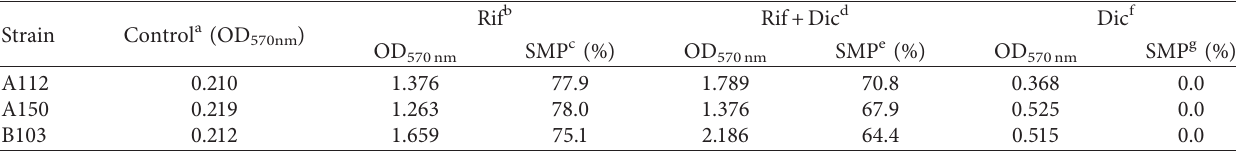
Figure 2: Biofilm production by two (a-b) isolates of S. aureus in tryptone soy broth (TSB) added of subinhibitory concentrations of diclofenac. The horizontal dashed line indicates the cutoff value that separates production from nonproduction of the biofilm. Assays were repeated three times with similar results, and error bars represent mean with range. (a) A150. (b) A116. Table 1: Degree of degradation of biofilm induced by rifampicin (1/2 MIC) and diclofenac after treatment with sodium metaperiodate in 3 strains of S. aureus .